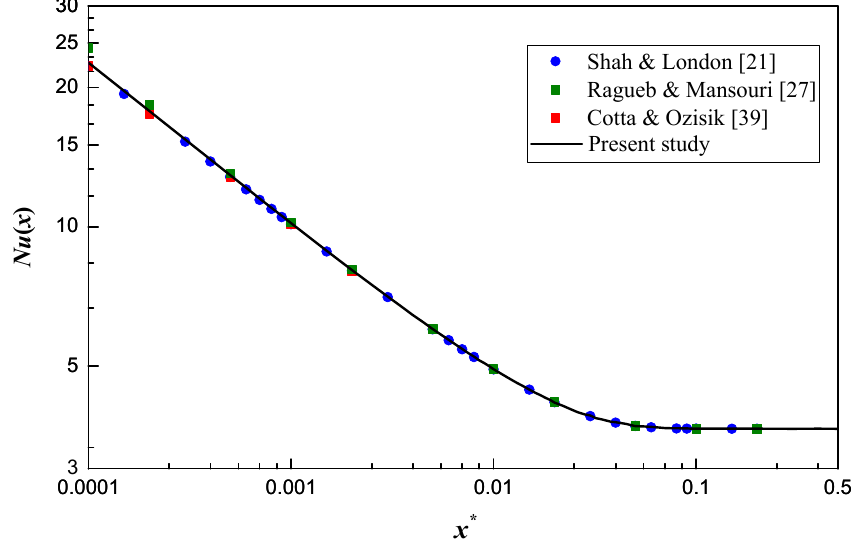
Figure 3. Validation of the numerical model for the thermal developing flow in a circular channel ( ε = 1).